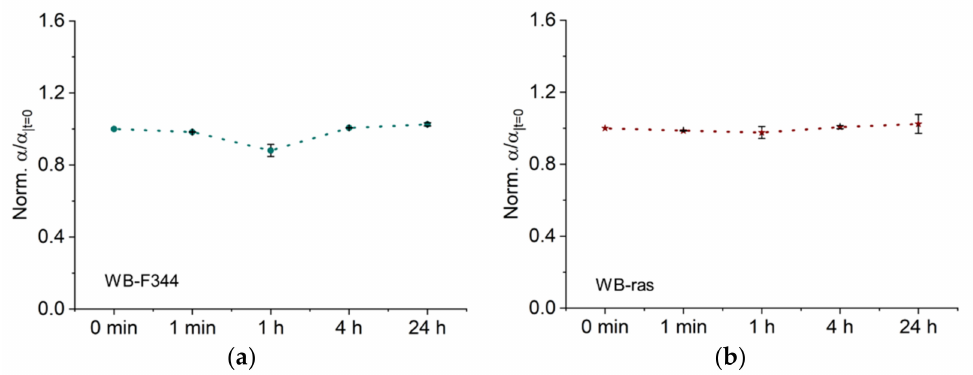
Figure 5. Dispersion width α as a function of time after CAP treatment of two cell monolayers, WB-F344 ( a ) and WB-ras ( b ).